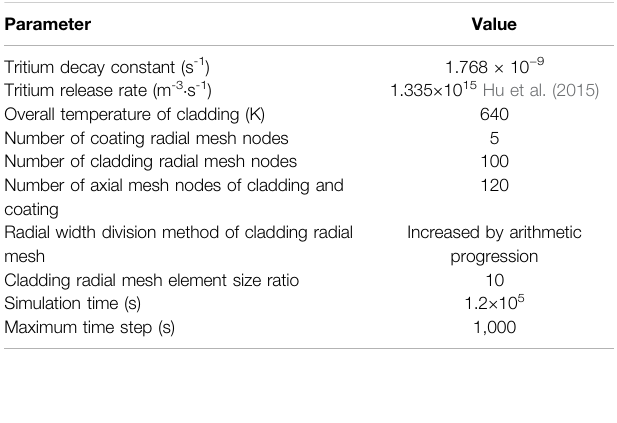
TABLE 2 | Simulation parameters.